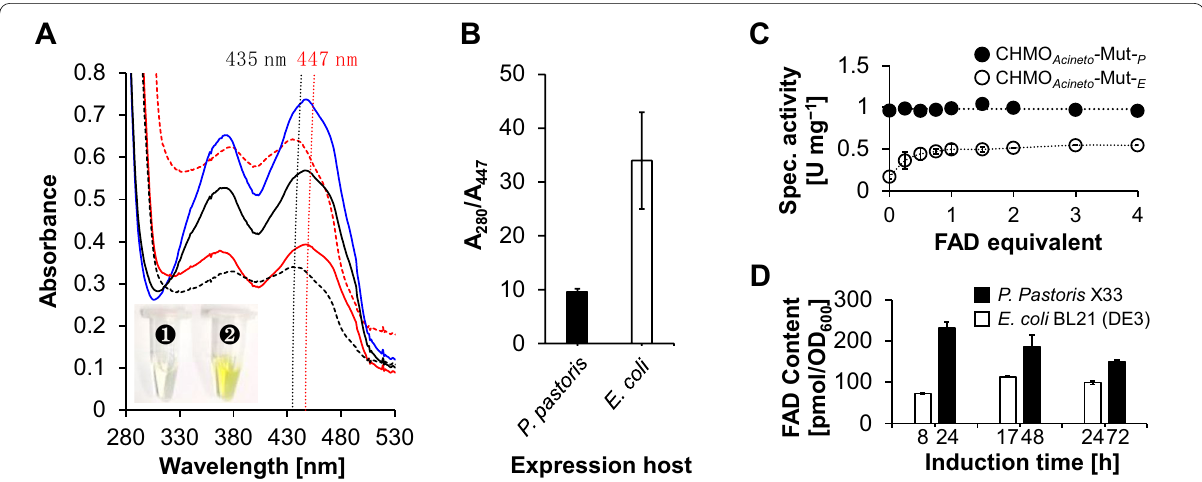
Fig. 2 A Representative UV‑visual spectrum of CHMO Acineto ‑Mut‑ P (red dash line), CHMO Acineto ‑Mut‑ E (black dash line), free FAD (blue solid line), boiled CHMO Acineto ‑Mut‑ P (black solid line) and boiled CHMO Acineto ‑Mut‑ E (red solid line); and photograph showing the color of CHMO Acineto ‑Mut‑ E , CHMO Acineto ‑Mut‑ P with the same concentration (5 mg/mL). B Calculated A 280 /A 447 value of CHMO Acineto ‑Mut expressed by different hosts according to the UV–Vis spectrum analysis. C Specific activity of CHMO Acineto ‑Mut‑ P ( □ ) and CHMO Acineto ‑Mut‑ E ( ○ ) supplied with different amounts of free FAD. D Intracellular FAD constitution of P. pastoris X33 and E. coli BL21 (DE3) during the expression of CHMO Acineto